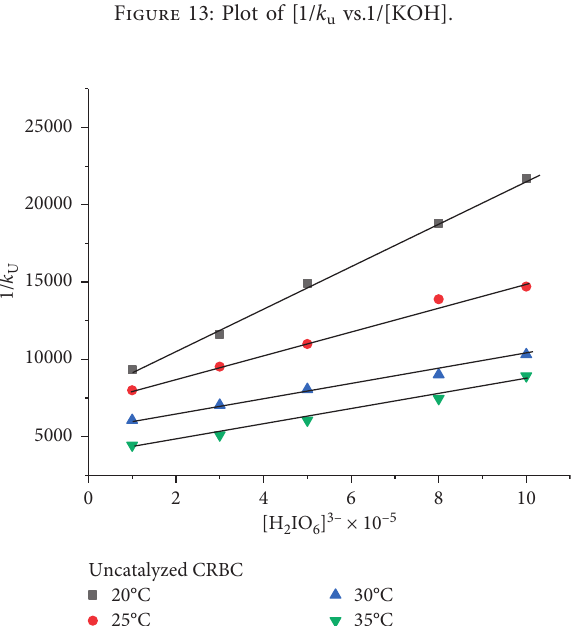
Figure 13: Plot of [1/ k u vs.1/[KOH].